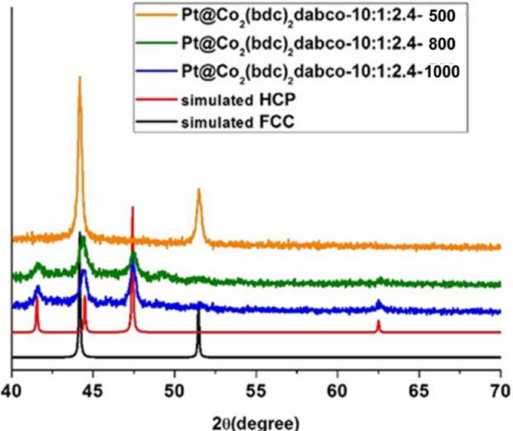
Figure 8. PXRD analysis of Pt@Co/C(10.1.2) at different carbonization